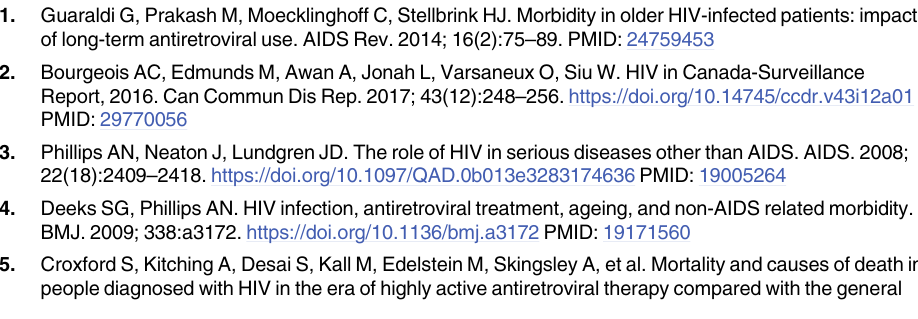
S3 Table. Health care services utilization and costs for HIV-positive patients with bone comorbidity and for a matched control group of HIV-negative patients with bone comor- bidity by age group. S4 Table. Health care services utilization and costs for HIV-positive patients with CV comorbidity and for a matched control group of HIV-negative patients with CV comor- bidity by age group. S5 Table. Health care services utilization and costs for HIV-positive patients with renal comorbidity and for a matched control group of HIV-negative patients with renal comor- bidity by age group. S6 Table. Mean total healthcare costs for PLHIV with at least 1 comorbidity vs. matched PLHIV without